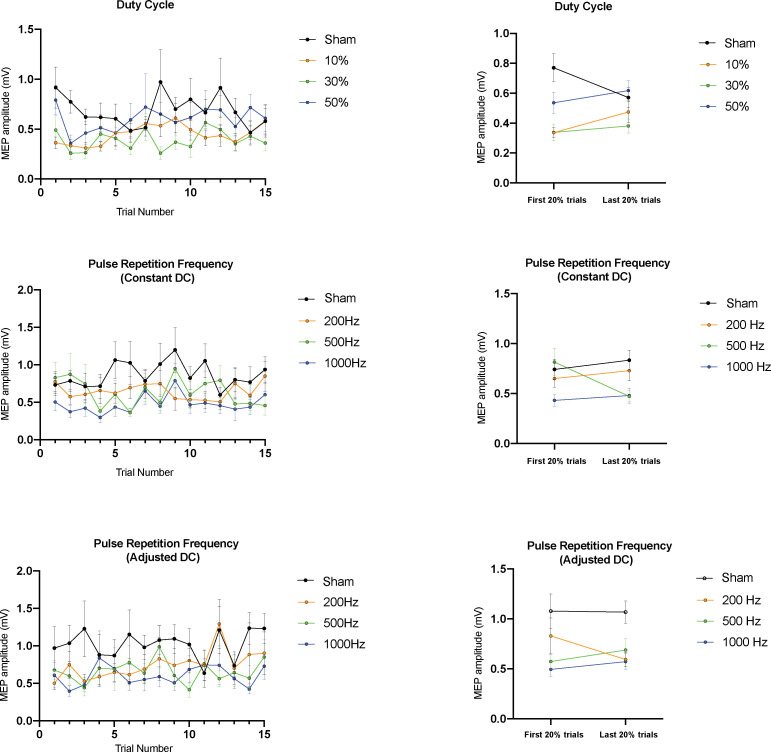
Post-hoc analysis of blocked delivery of ultrasound parameters by trial number (N = 16).The left panels plot the mean TMS-induced resting peak-to-peak MEP amplitudes stratified by trial number within the block for the three parameter condition sets tested. The right panels compare early to late trials across conditions. In the blocked Duty Cycle experiment, no significant differences between early and late trials were found in the sham, 10%, 30%, or 50% conditions (p=0.31, 0.31, 0.81,0.81, paired t-tests). Similarly, in the blocked PRF experiments, no differences were found between early and late trials within the sham, 100, 500, or 1000 Hz conditions when DC was held constant (p=0.09, 1.0, 1.0, 1.0, paired t-tests) or adjusted (p=0.92, 1.0, 1.0, 1.0, paired t-tests). Error bars represent standard error, and p-values are adjusted with the Holm-Bonferroni method (α = 0.05).